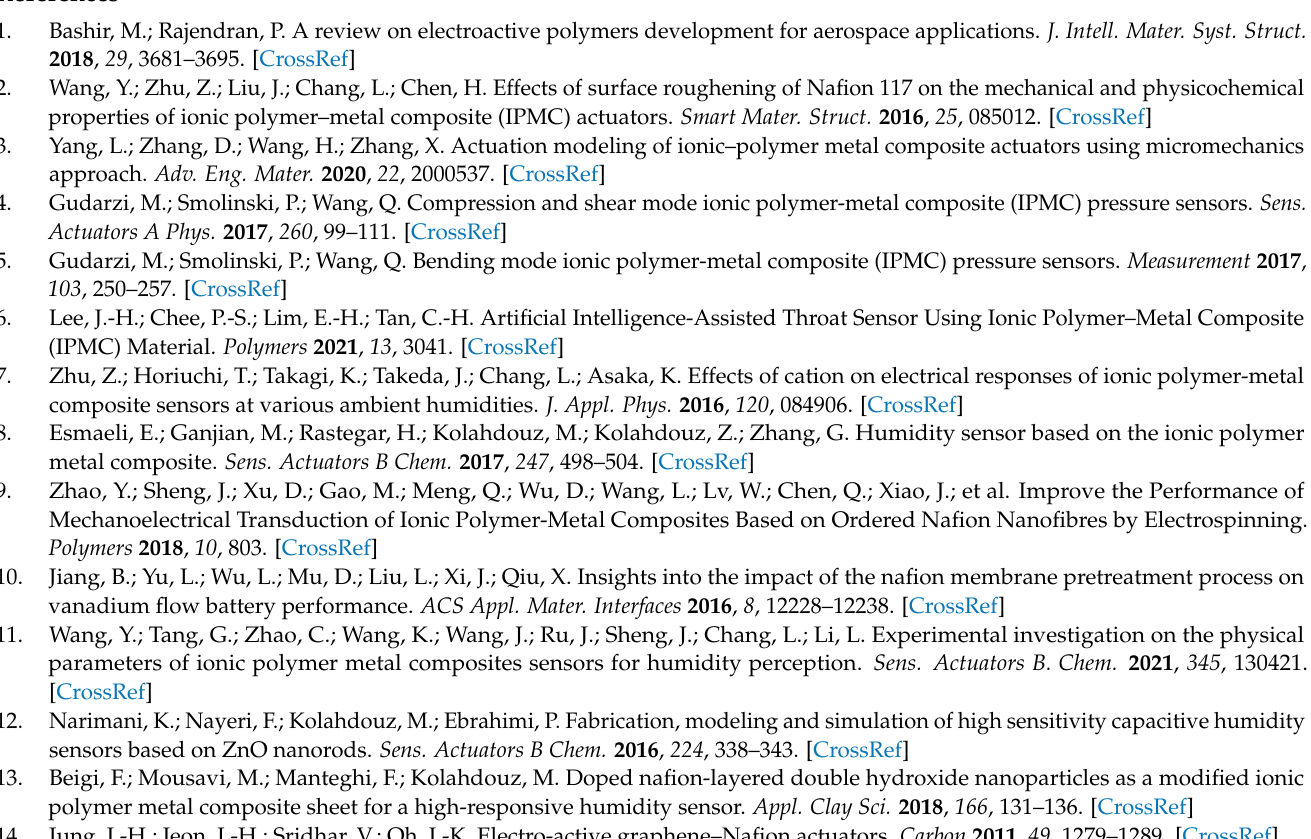
(d); Figure S2: Humidity measurement setup; Table S1: Comparative table of different